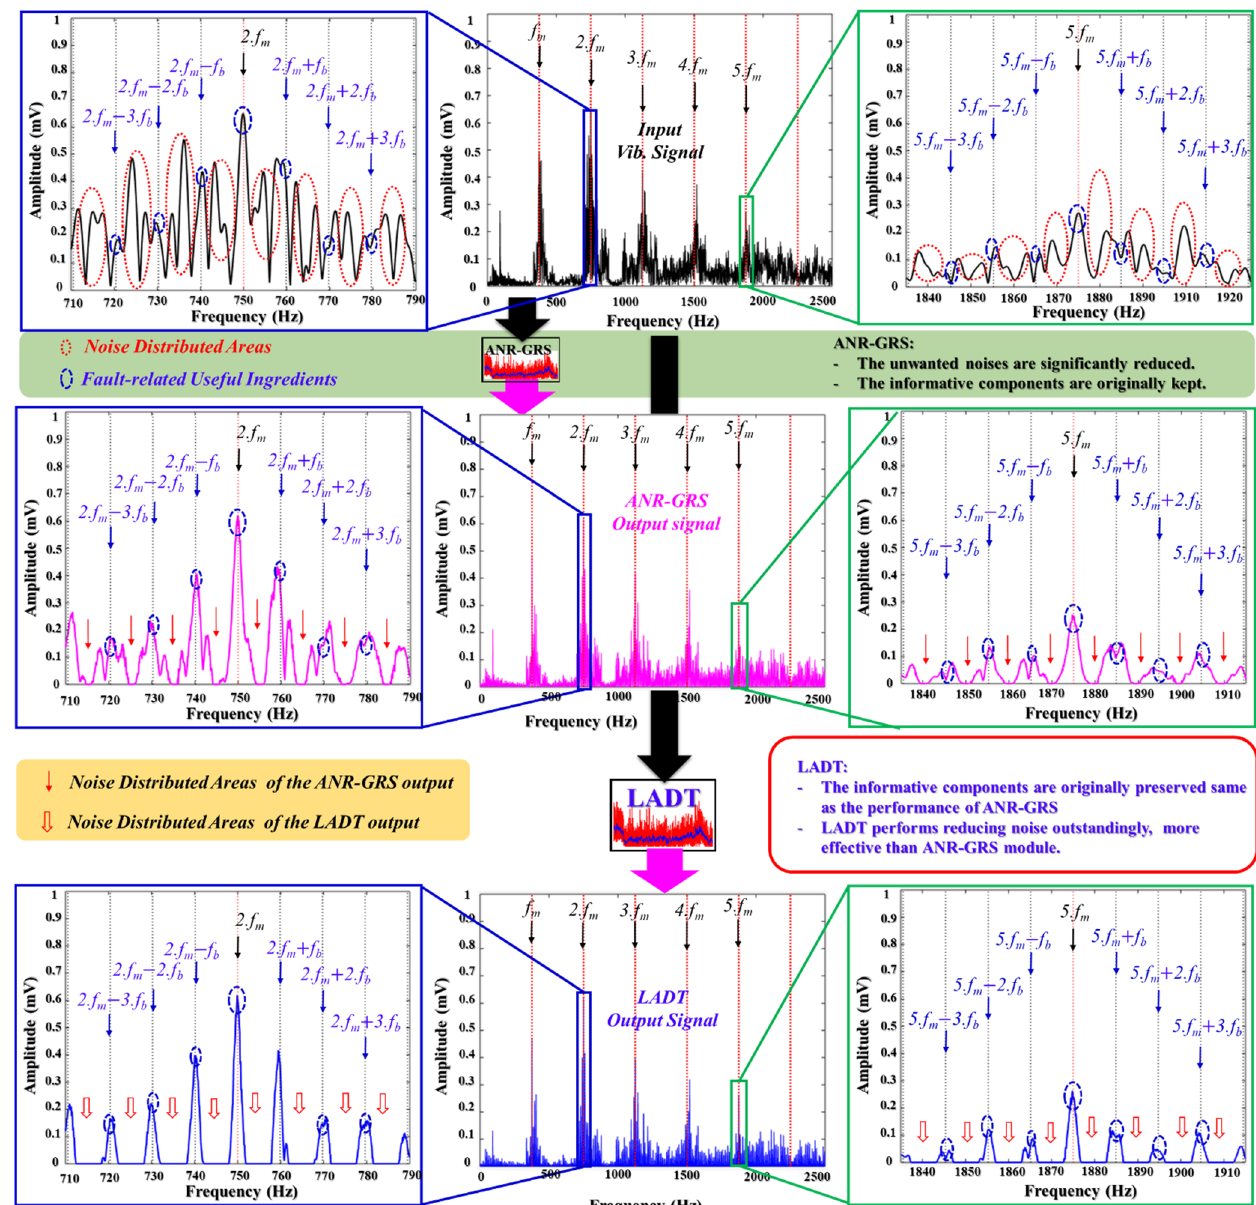
Figure 10. The frequency spectrum analysis of the input and output signals of LADT in comparison with the performance of ANR-GRS for an example vibration signal of DT3 at 900 RPM.